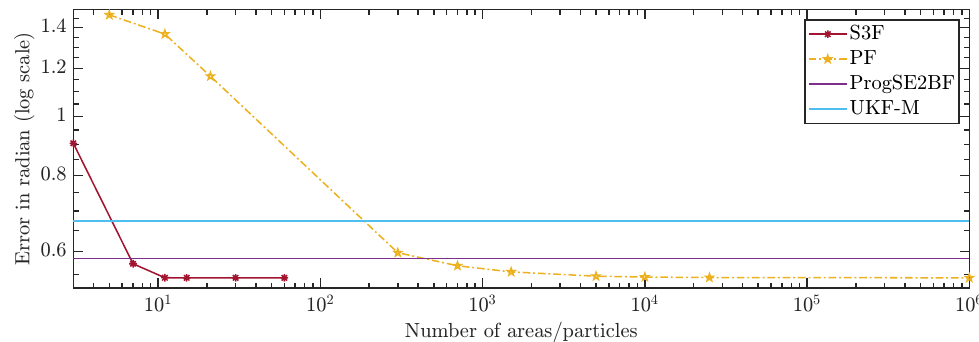
Figure 11. Orientation error over number of areas or particles. The run times of the filters are shown in Figure 12. We can see that the S3F is much slower per area than the PF per particle, which was expected. We also observe an expected faster increase in the run time for the S3F. While the PF is in O ( n ) , the S3F is in O ( n 2 ) . The S3F is faster than the ProgSE2BF in all considered configurations. The PF with 25,000 parti- cles had a run time similar to that of the ProgSE2BF but required much more run time with 1,000,000 particles. The UKF-M was faster than all other filters except the PF with 21 or fewer particles.